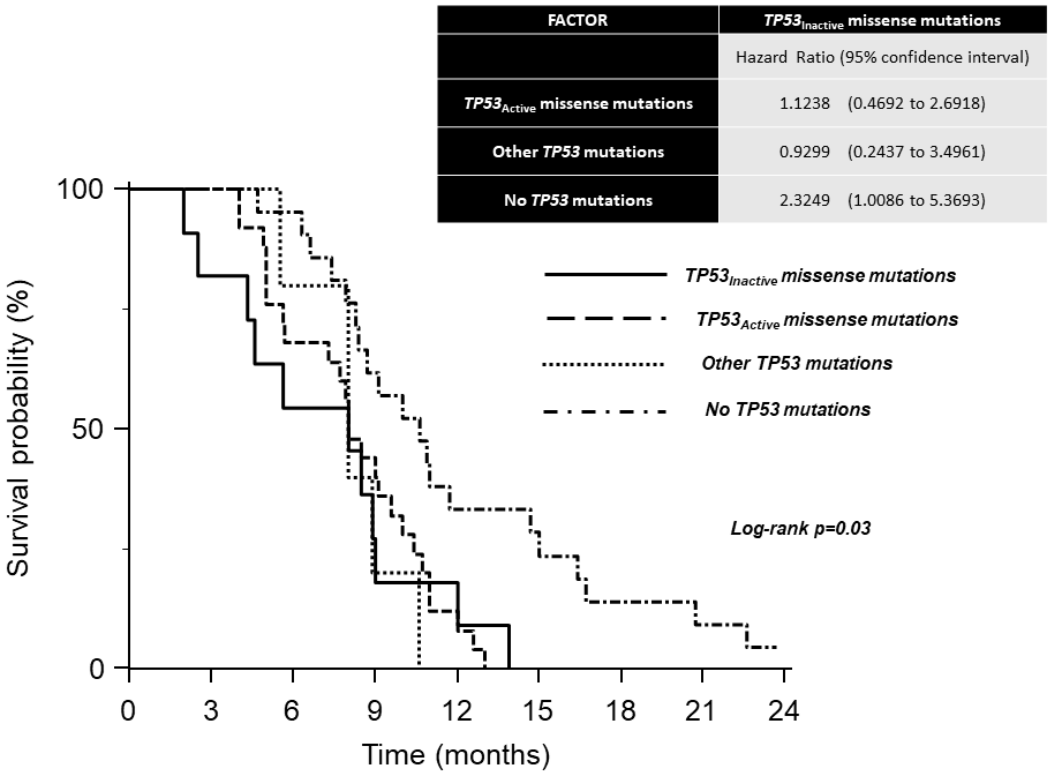
Figure 3. Kaplan–Meier survival curves of first-line combination chemotherapy in 62 patients with metastatic gastric cancer.